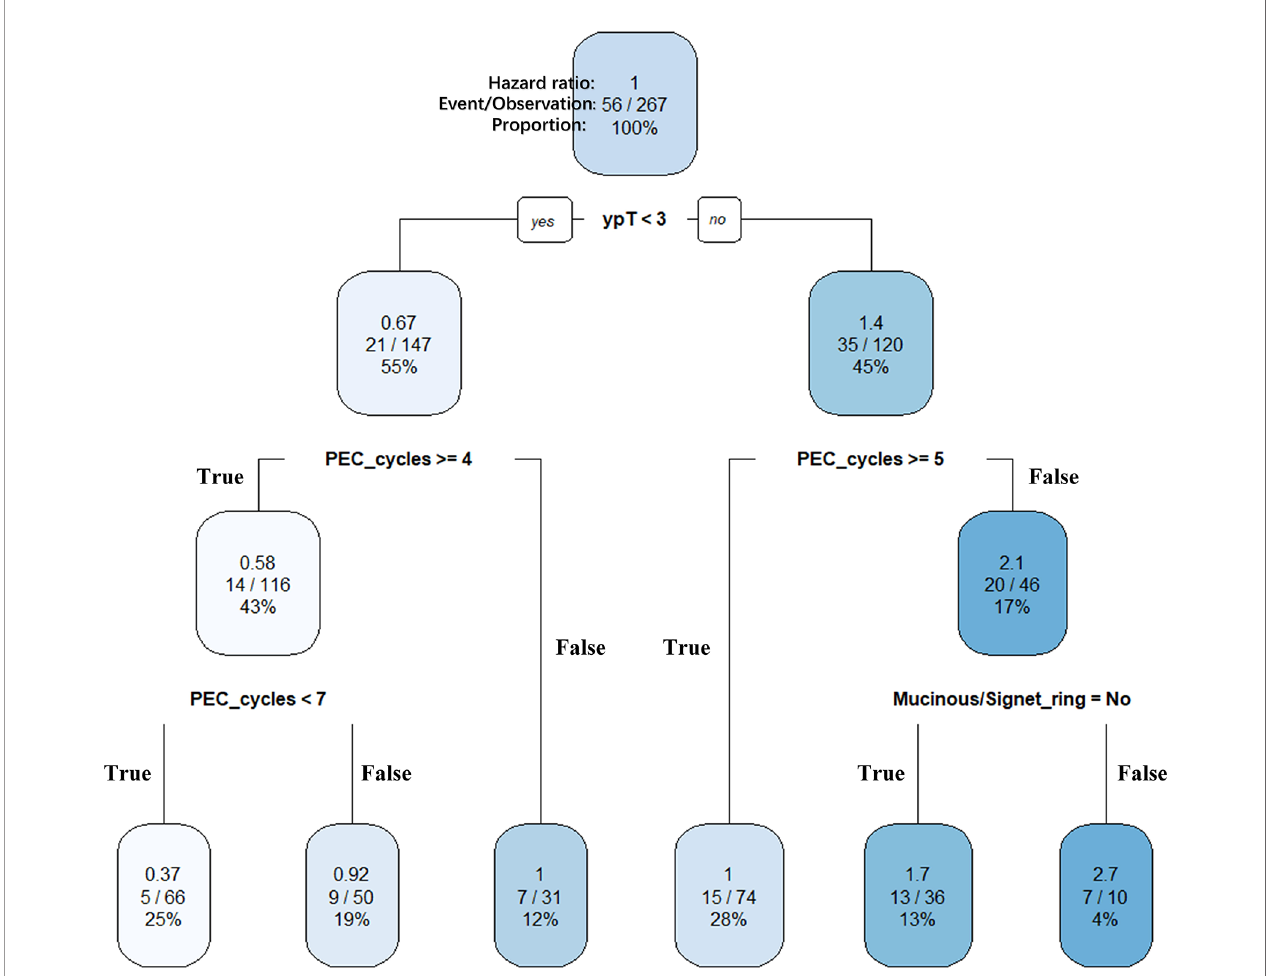
FIGURE 6 | Clinically interpretable decision tree for relative survival risk. ypT (continuous variable from ypT1a to ypT4b), PEC cycles (continuous variable from 1 to 10), and histological type (dichotomous variable) were selected as key features for the fi nal pruned decision tree for overall survival. The predicted hazard ratio in each splitting group using overall samples as reference. Within each internal nodes (conditions), the sub-branch is shown on the left when the condition is True (Yes) and shown on the right when the condition is False (No). The ypT < 3 was set as the root node. Splitting covariate is indicated within each node. The number under each node identi fi es each subgroup. Six terminal nodes were then identi fi ed as follow: node 1, ypT0-2&PEC4-6; node 2, ypT0-2&PEC ≥ 7; node 3, ypT0-2&PEC ≤ 3; node 4, ypT3-4&PEC ≥ 5; node 5, ypT3-4&PEC<5&non-mucinous; and node 6,